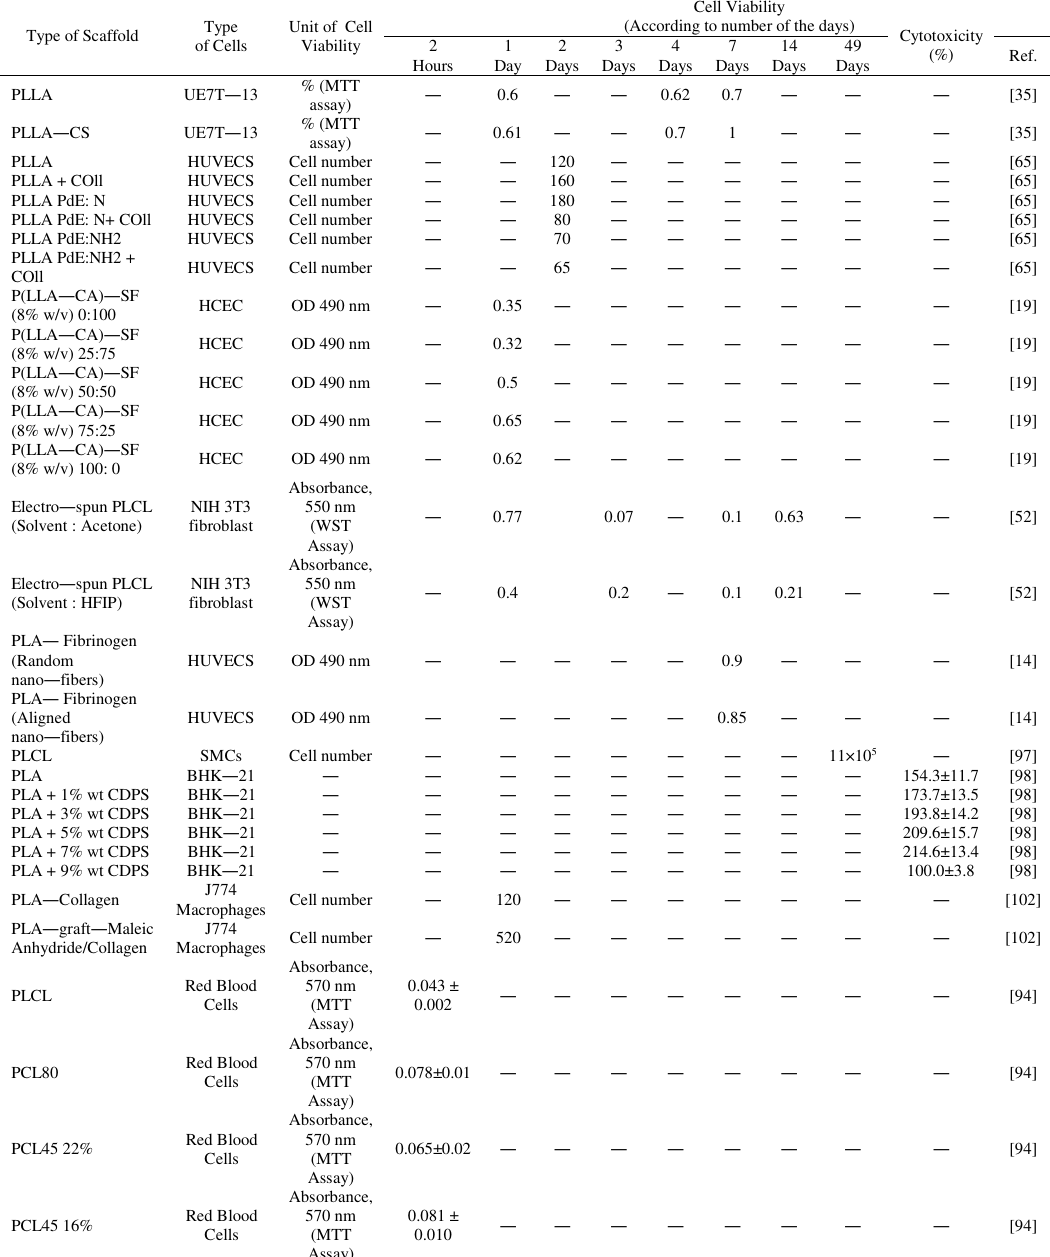
Table 3 : Cytotoxicity and Cell Viability on PLA Vascular